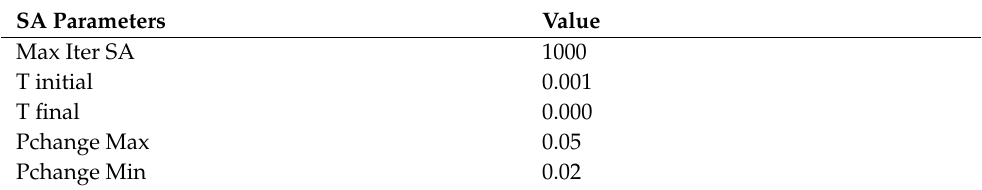
Table 2. SA Parameter